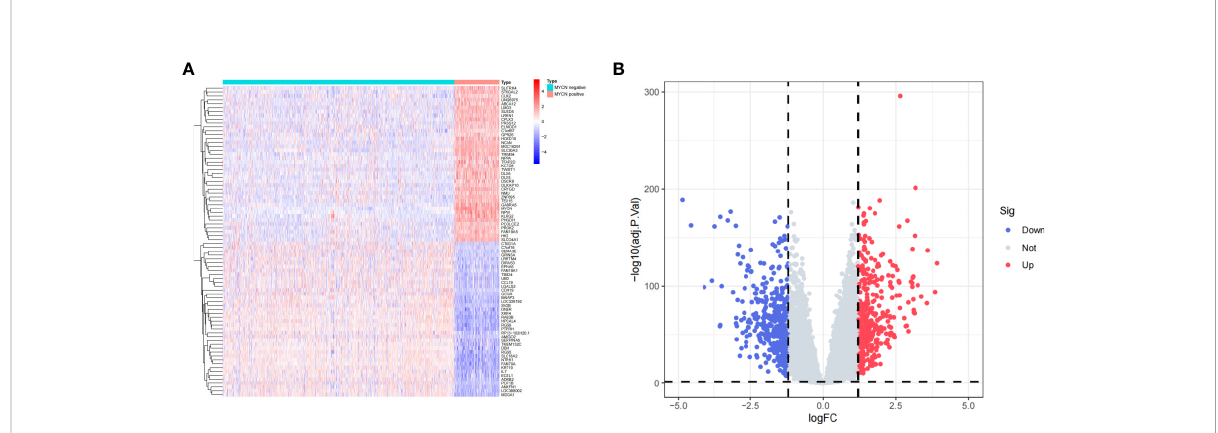
FIGURE 2 Identi fi cation of DEGs (A) Heatmap of representative DEGs in MYCN positive and MYCN -negative NB tissues. (B) Volcano plot of all genes in NB tissues. The vertical dotted lines represent |log2fc|= 1.2, the horizontal dotted lines represent p-value=